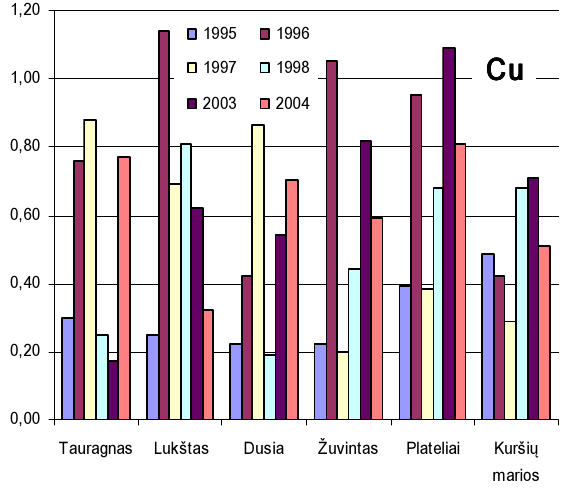
Fig. 4. Dynamic of heavy metal (Cu) concentrations (mg/kg) in perch and roach muscles from monitored water G. Svecevičius ir M. Vosylienė (1996) ištyrė ūminį vario toksiškumą penkiose gėlavandenių žuvų rūšyse ir